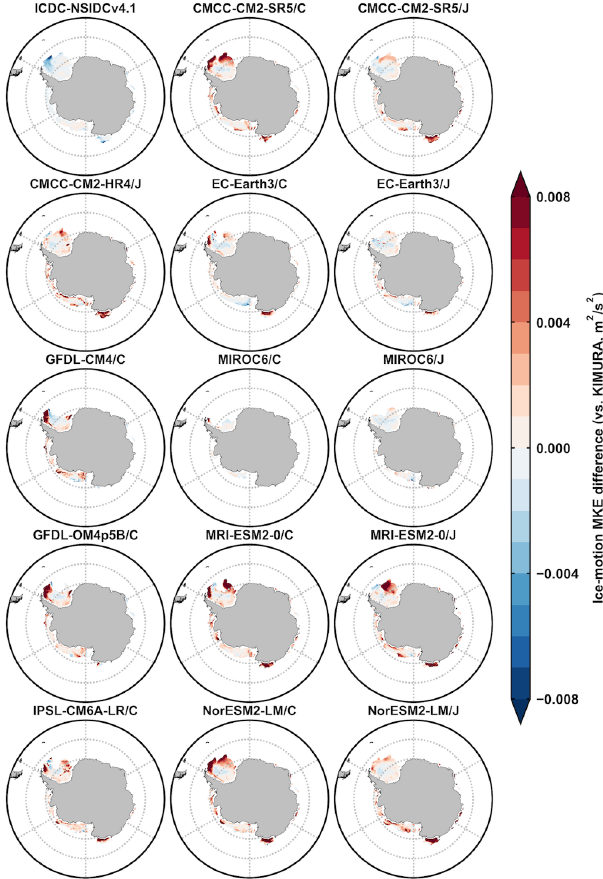
Figure A12. The 2003–2007 September mean Antarctic MKE differences between ICDC-NSIDCv4.1/model outputs and the KIMURA data (m 2 s − 2 ). The second and third columns are from the five OMIP1 and OMIP2 model outputs of CMCC-CM2-SR5, EC-Earth3, MIROC6, MRI-ESM2-0, and NorESM2-LM, respec-